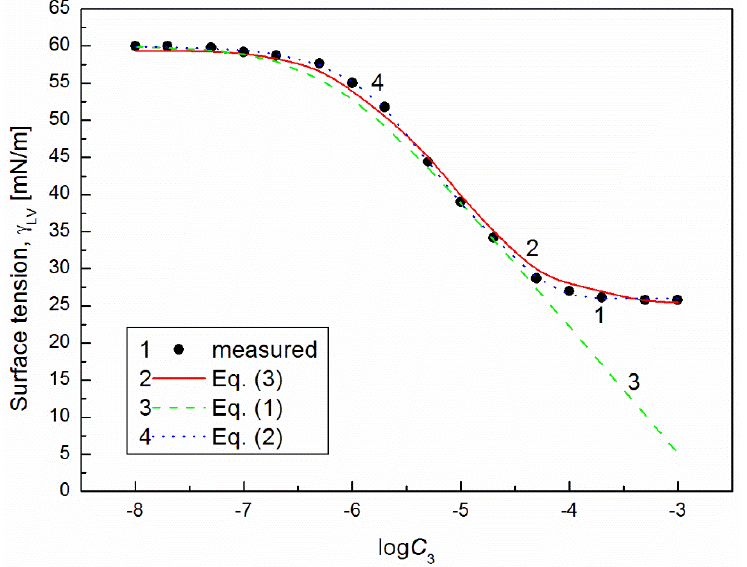
Figure 1. A plot of the surface tension ( γ LV ) of the aqueous solutions of CTAB + TX100 + FC1 mixture at the constant concentration of the binary mixture CTAB + TX100 ( C 12 ) and γ LV = 60 mN/m (m1 (60)) vs. the logarithm of FC1 concentration ( logC 3 ). Points 1 correspond to the measured values, curves 2, 3 and 4 correspond to the values calculated from the Fainerman and Miller (Equation (3)), the Szyszkowski equation (Equation (1)) and the second order exponential function (Equation (2)), respectively.